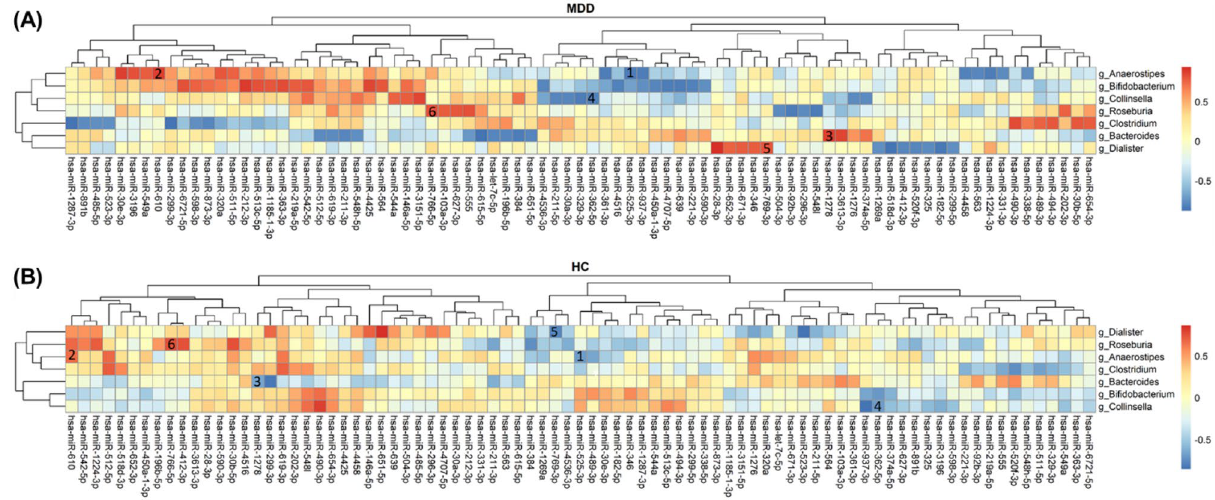
Figure 3. Two Correlation heatmaps between 7 genera and 83 miRNAs. The strength of correlation was measured by the Spearman correlation coefficient. Red indicates positive correlation, and blue indicates negative correlation. The numbers in some cells highlight the pairs which had significant correlation in both the HC and MDD groups. ( A ) In the MDD group, 36 positive-correlation pairs and 48 negative-correlation pairs had a p-value less than 0.01. ( B ) In the HC group, six pairs had significant correlations, which were ( Anaerostipes , miR-525-3p), ( Anaerostipes , miR-610), ( Bacteroides , miR-1278), ( Collinsella , miR-362-5p), (Dialister , miR- 769-3p), and ( Roseburia ,